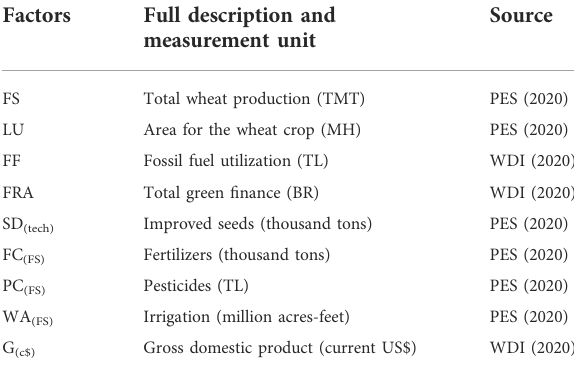
TABLE 1 Variables pro fi le, measurement, and